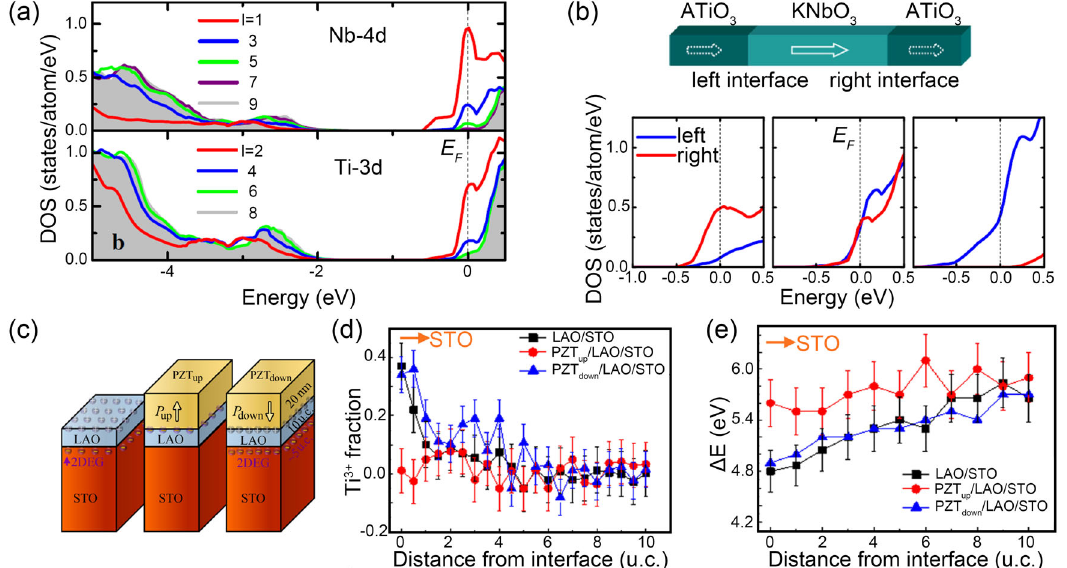
Fig. 3 Ferroelectric polarization modulated the conductivity at the heterointerface. a , b KNbO 3 /ATiO 3 (A = Sr, Ba, Pb) heterointerface. The density of state (DOS) projected onto ( a ) Nb-4 d states and ( b ) Ti-3 d states, which are located at different monolayers l away from the (NbO 2 ) + / (SrO) 0 interface for a paraelectric state of (KNbO 3 ) 8.5 /(SrTiO 3 ) 7.5 superlattice. Reproduced with permission from ref. 95 . Copyright [2009] {American Physical Society}. c – e LaAlO 3 /SrTiO 3 heterointerface. c The schematic of bare LAO/STO, PZT up /LAO/STO, and PZT down /LAO/STO interface. d , e Evolution of Ti 3 + fraction and Δ E (O K-edge) with distance from the interface. Reproduced with permission from ref. 94 . Copyright [2018] {American Chemical